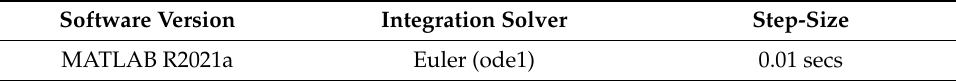
Table 1. Software configuration for simulations reported in Section